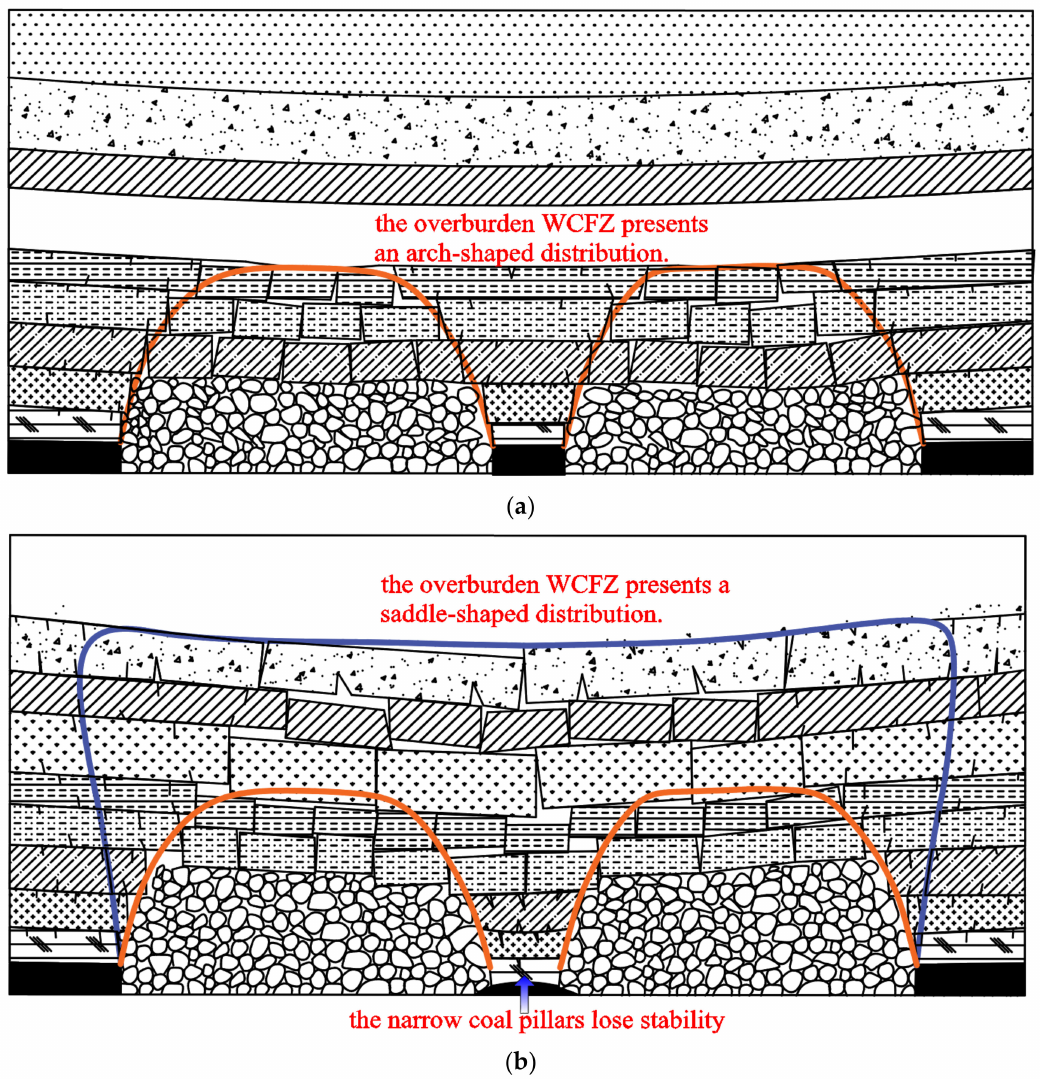
Figure 7. Distribution of WCFZ during overburden mining degree transformation. ( a ) Arch-shaped distribution. ( b ) Saddle-shaped